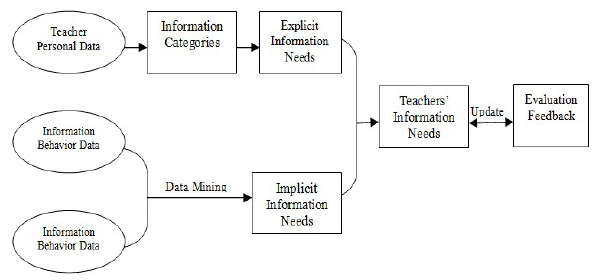
Figure 2: Framework of Information Demand Model for Maker